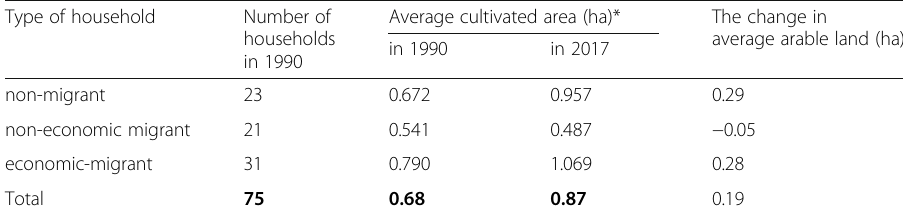
Table 4 Average agricultural area per household (ha) Type of household Number of households